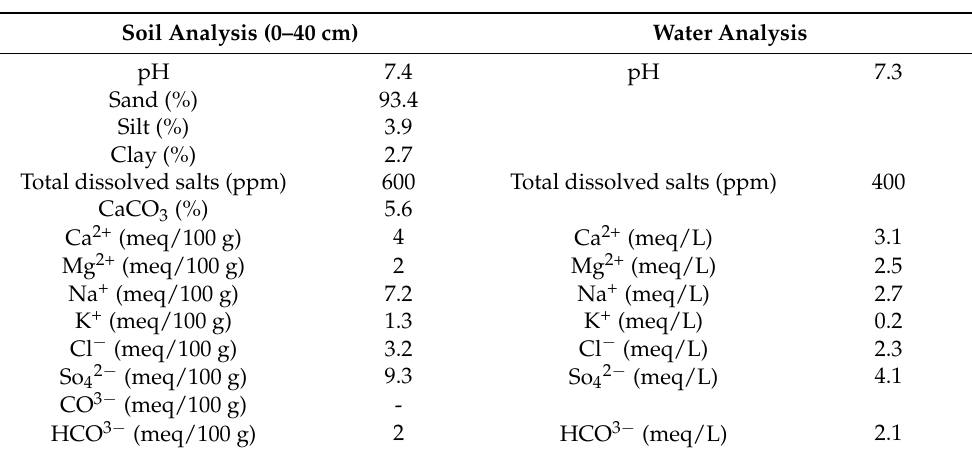
Table 2. Soil and water analysis of the experimental